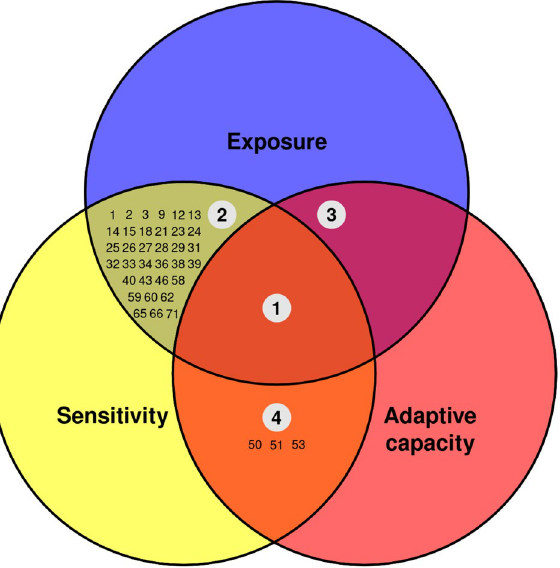
Figure 7. Distribution of species according to the vulnerability categories described by Foden et al. 47 . The combination of the three components of vulnerability define three categories of vulnerability addressing specific conservation implications. Area 1 “highly climate change vulnerable” comprises species with high or very high E and S, and low or very low AC. Area 2 “potential adapters” comprises species with high or very high E, S, and AC. Area 3 “potential persisters ”comprises species with high or very high E, and low or very low S and AC. Area 4 “high latent risk” comprises species with high or very high S, but low or very low E and